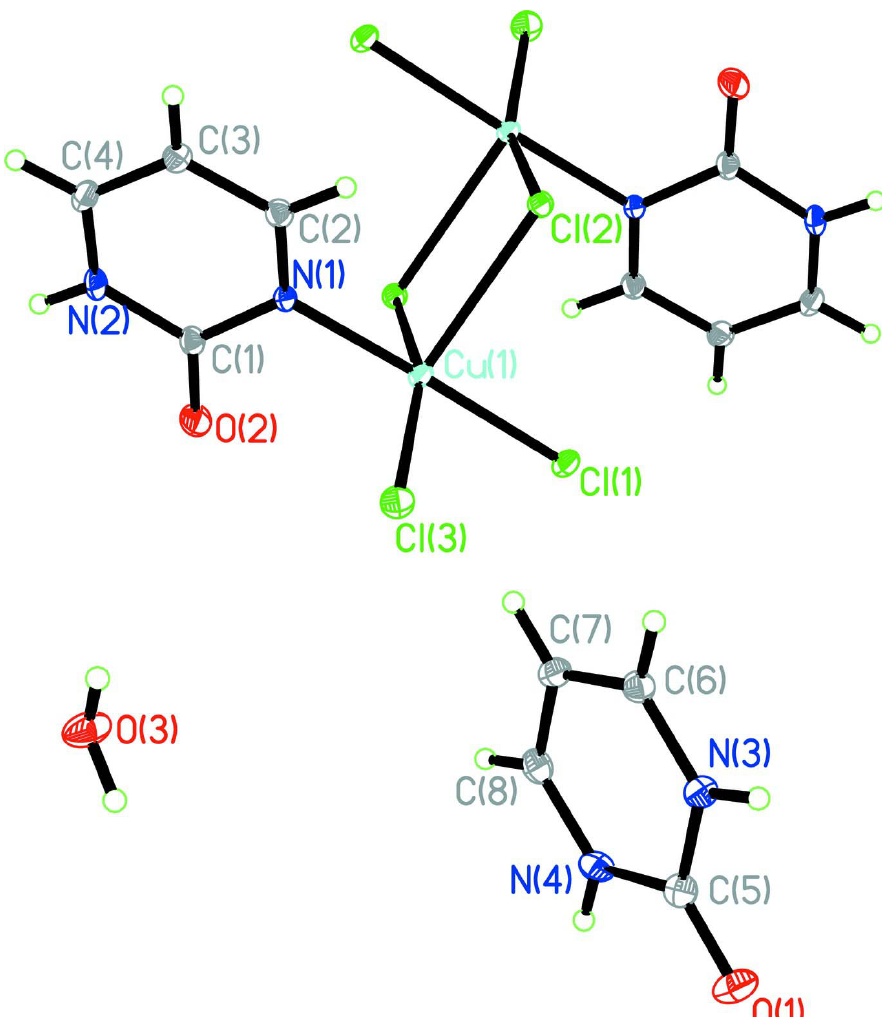
Figure 1 The molecular structure of I showing one dimeric dianion, one cation and a molecule of water of crystallization, with atom labels and 50% probability displacement ellipsoids for non-H